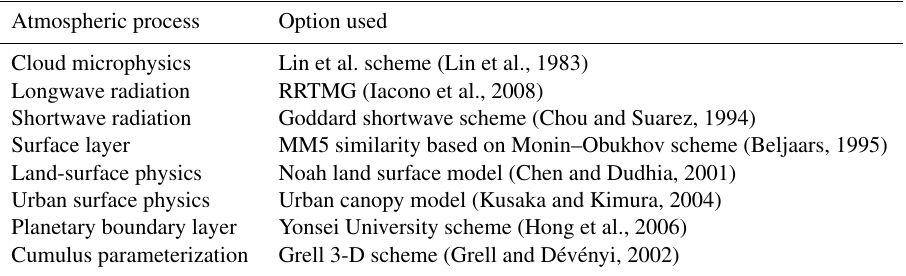
Table 1. WRF-Chem options used in model